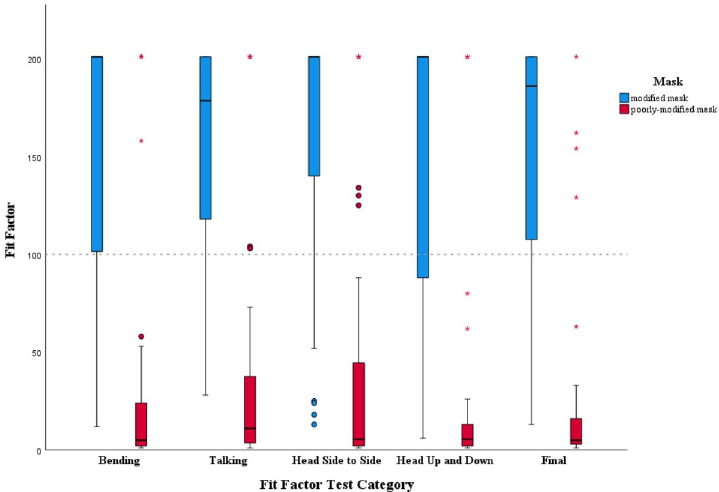
Fig 3. A comparison of appropriately modified and poorly-modified mask performance using quantitative PortaCount fit testing. Fit Factor subscores of bending, talking, head side to side, and head up and down, as well as Final PortaCount Fit Factor scores are presented as boxplots. Boxplots are structured such that the horizontal line within the box indicates the median, the vertical length of the box is the IQR, and the whiskers demonstrate the minimum and maximum values excluding the outliers which are circles and stars. Circles are outliers that are 1.5 times the IQR. Stars are outliers that are 3 times the IQR. In each pairing, the properly modified group is on the left and the poorly-modified group is on the right. The dotted horizontal line through the 100 y-axis marker is the passing threshold.